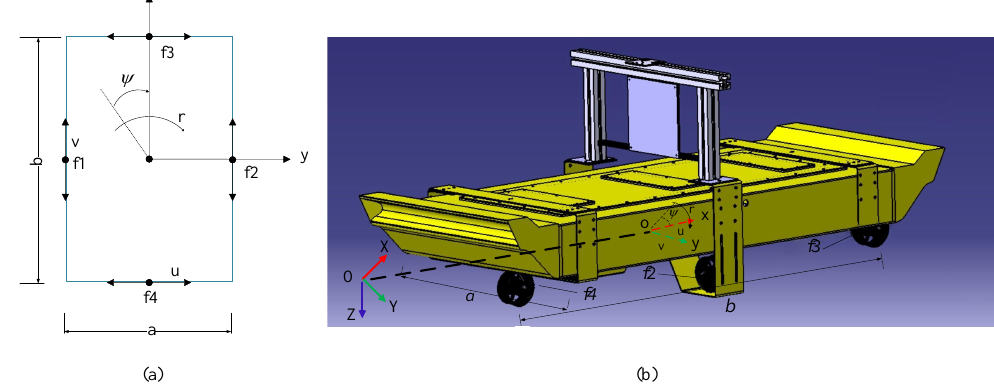
Figure 1. Design of the USV: ( a ) shape and force vectors in the USV; ( b ) mechanical design of the USV. The shape of the USV is designed as a rectangle for easier docking, and its length and width are b and a , respectively. There are four propellers on the USV, namely f 1 , f 2, f 3, and f 4, and they are fixed symmetrically. Among them, the direction of the thrusters’ force of f 1 and f 2 is along the x axis direction in the figure, and the direction of the thrusters’ force of f 3 and f 4 is depicted in the figure. The rear thruster and right thruster in Figure 1b correspond to f 4 and f 2 in Figure 1a,